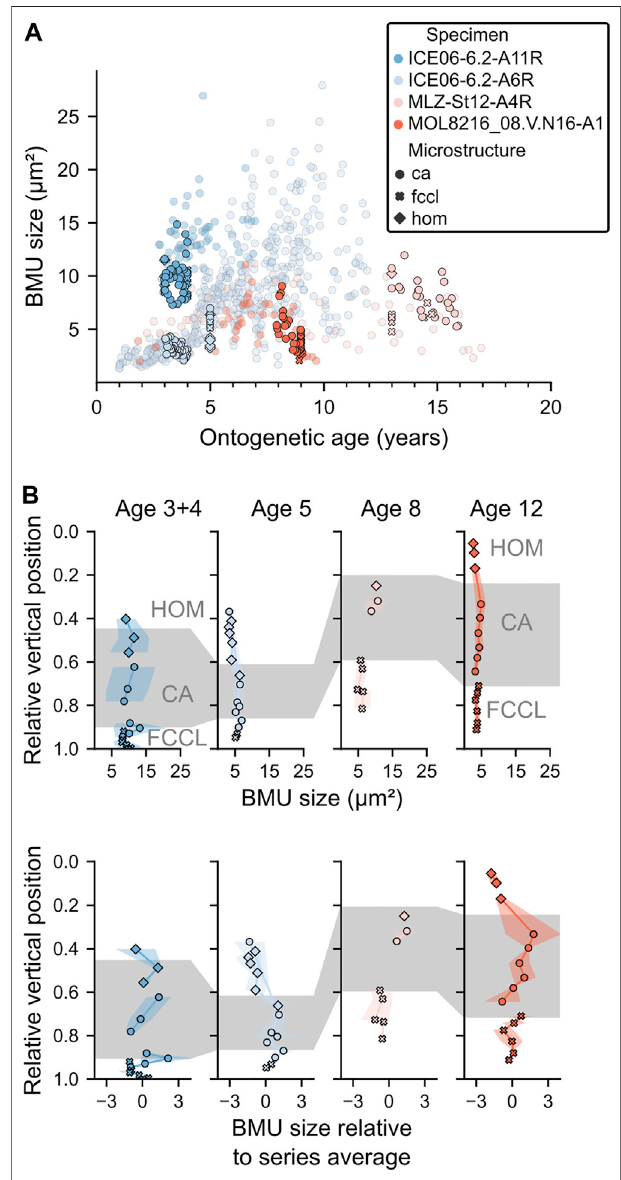
FIGURE 7 | BMU sizes in the ventral margin of Arctica islandica shells. (A) BMUs of the ventral margin (solid colors) and the hinge plate (transparent) were almost identically sized and showed the same size patterns over time. (B) BMU sizes in vertical transects through the outer shell layer (OSL) as absolute and relative values. From the outer shell surface toward the myostracum (i.e., 1.0 relative vertical position; x -axis), BMUs were smallest in the homogeneous (HOM) microstructures of the outer portion of the OSL, attained maximum sizes and largest size variances in the crossed-acicular (CA) microstructures of the inner portion of the OSL, and decreased again toward average sizes in the FCCL microstructure near the myostracum.